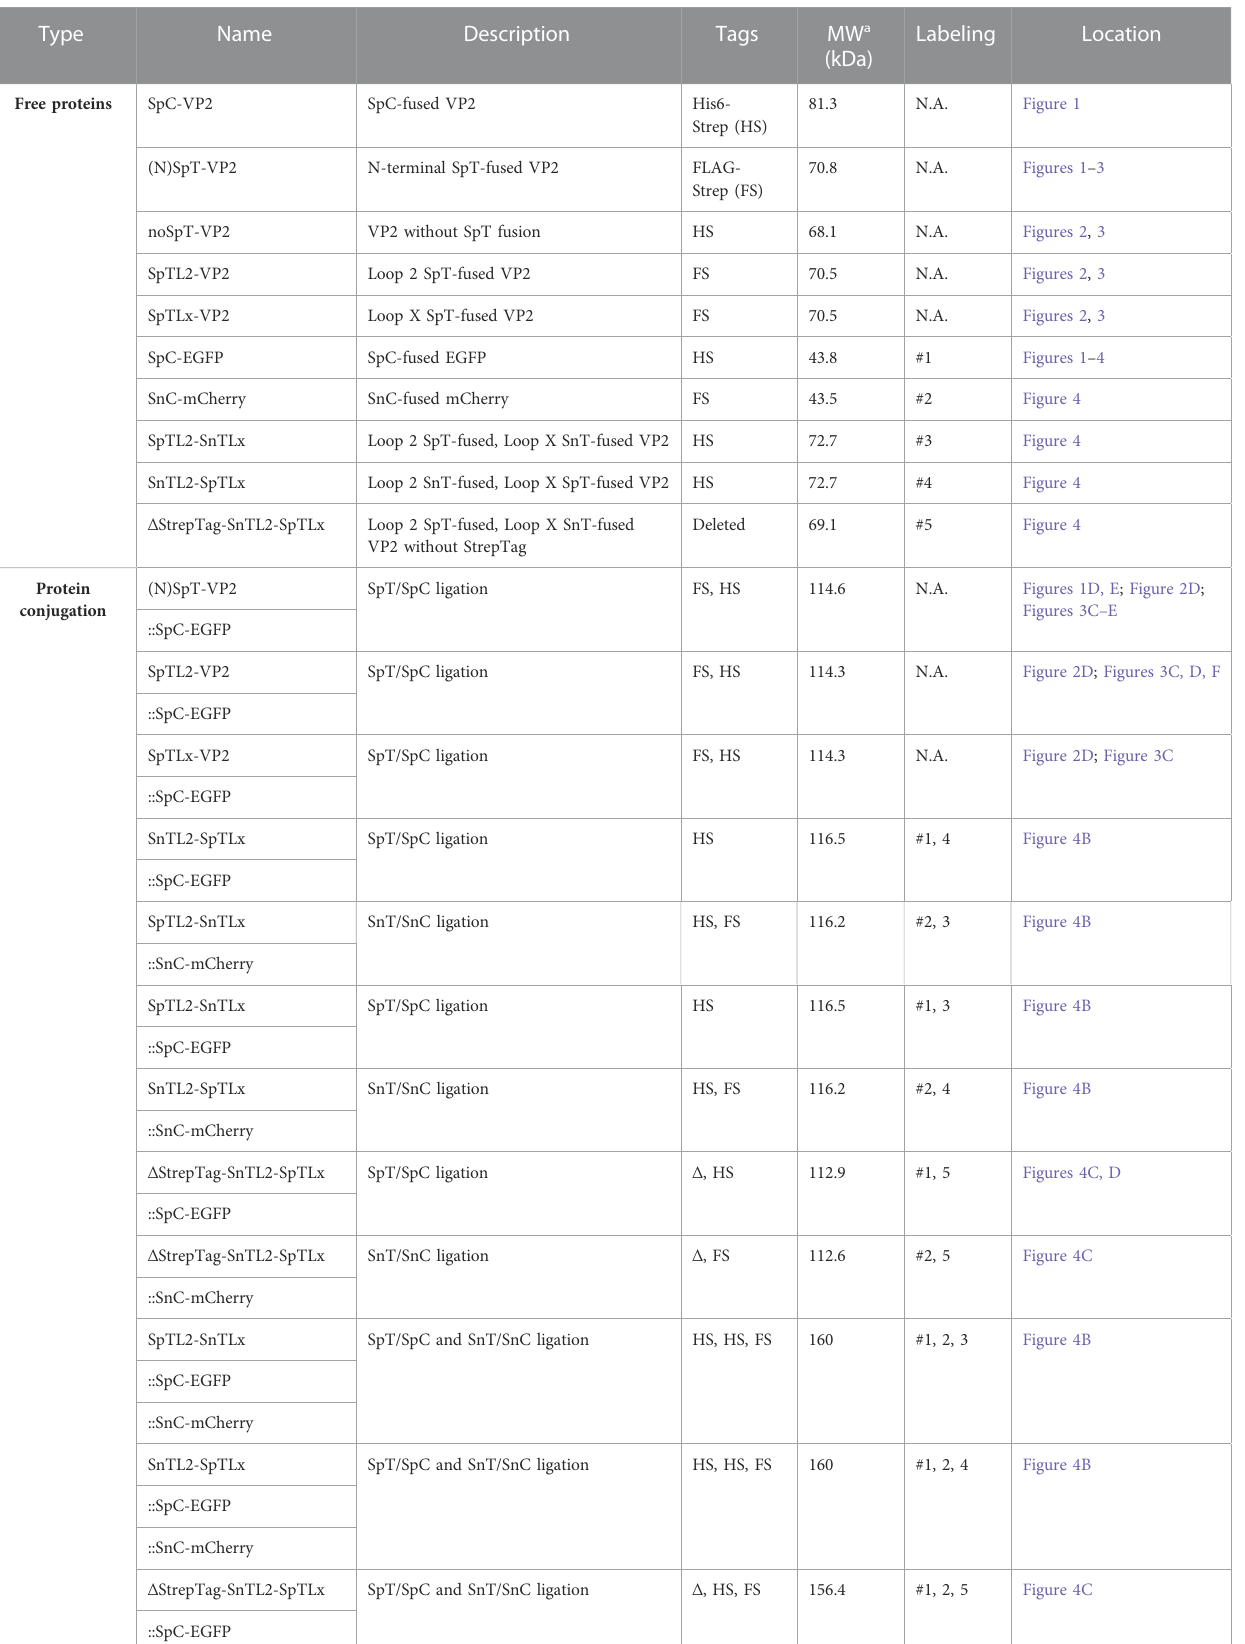
TABLE 2 Predicted molecular weight for the proteins used in this study.